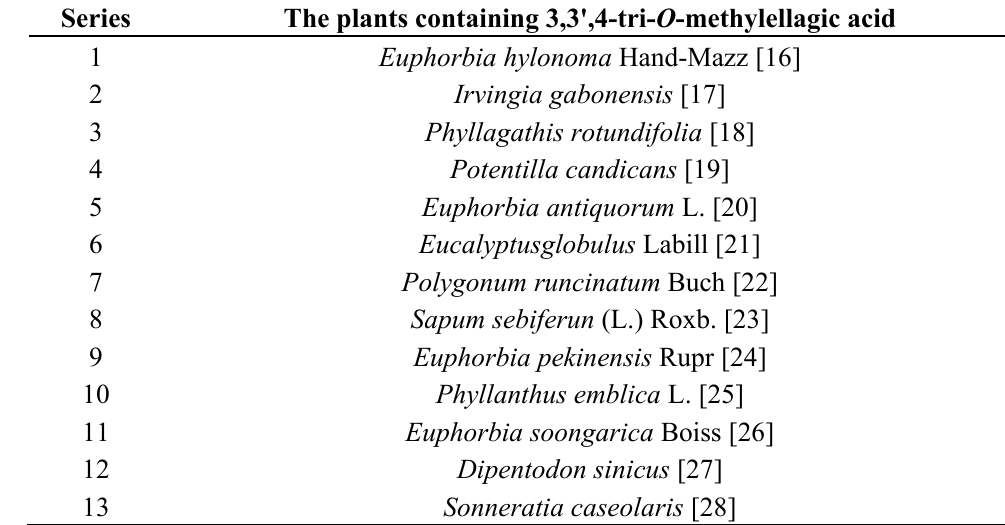
Table 2. The plants containing 3,3',4-tri- O -methylellagic